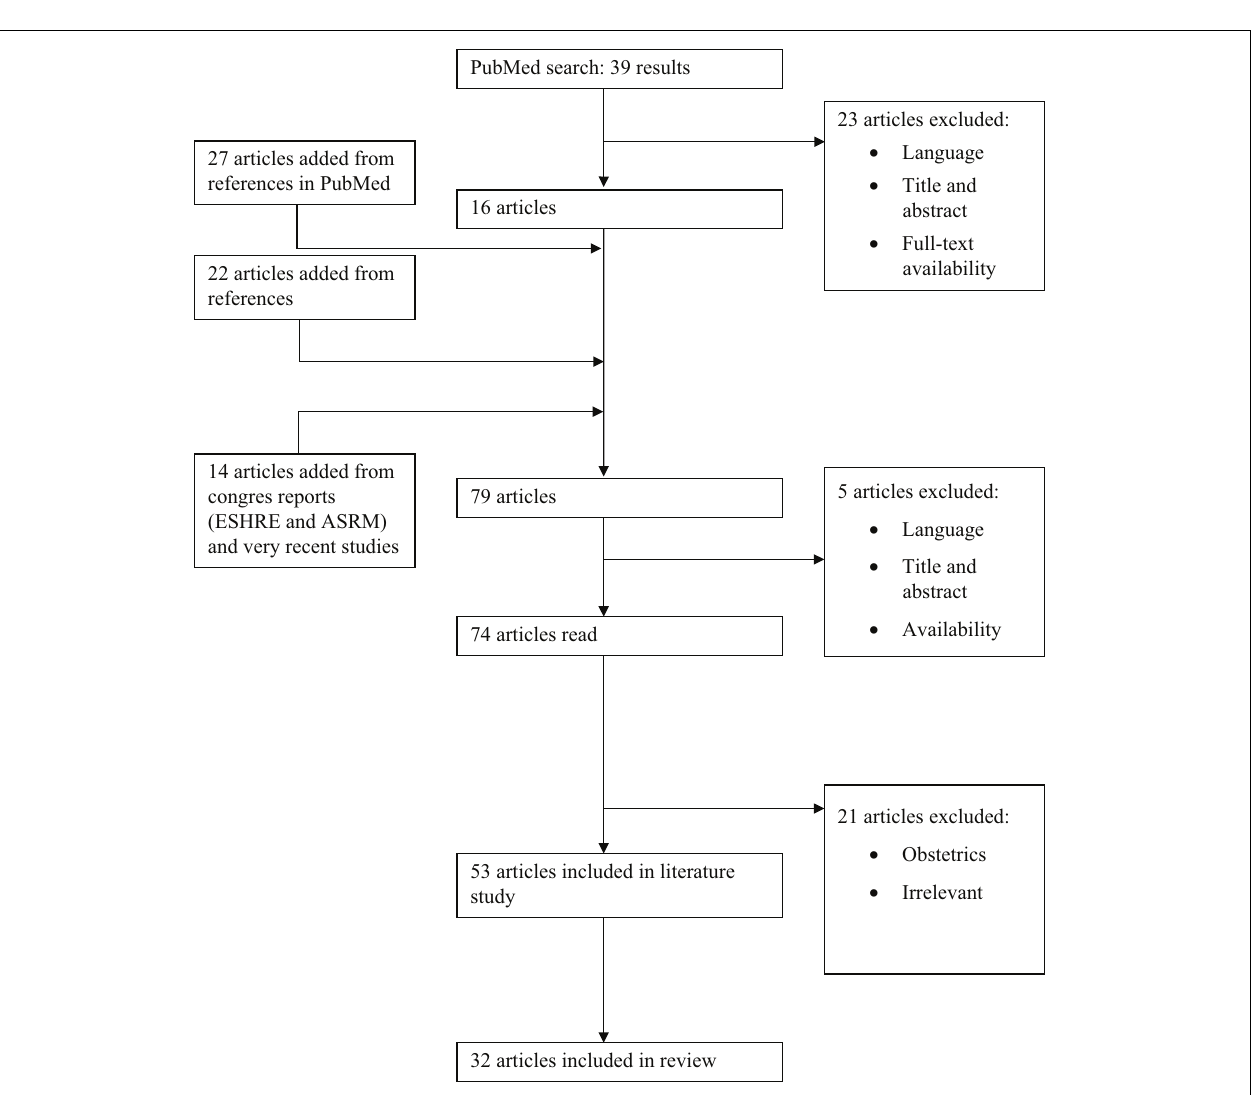
FIGURE 3 | Flow chart of the review process . ESHRE, European Society of Human Reproduction and Embryology; ASRM, American Society for Reproductive Medicine.